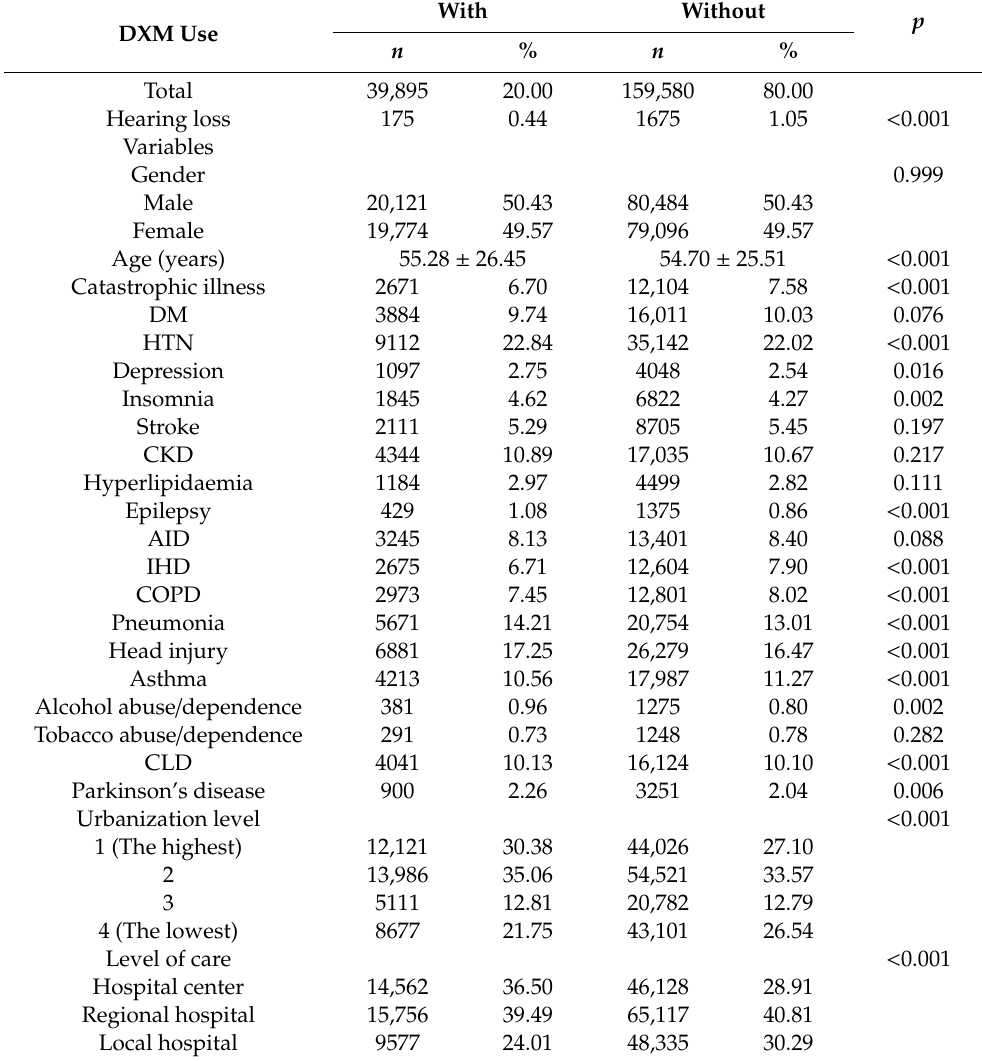
Table 1. Characteristics of study in the endpoint during the follow-up period from 1 January 2000 to 31 December